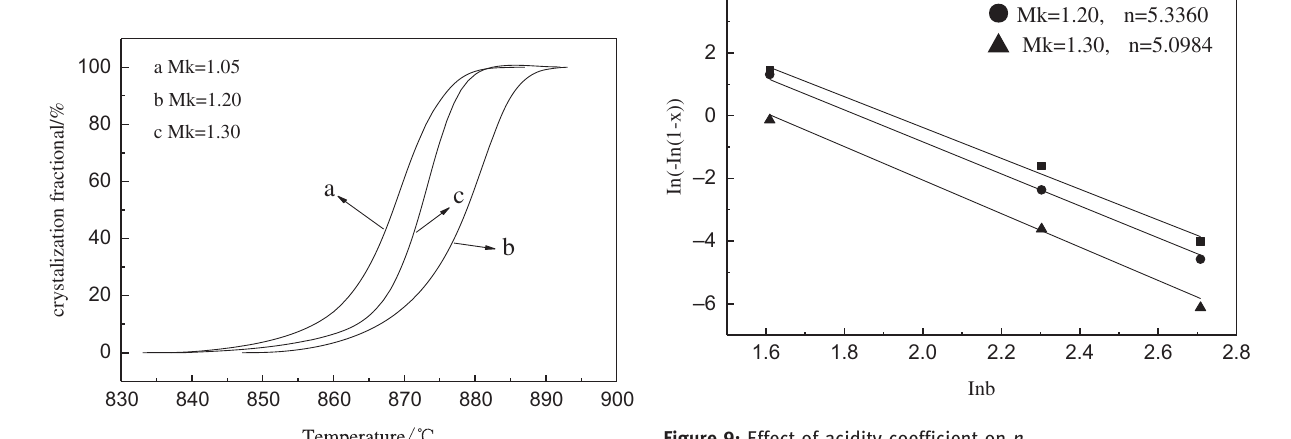
Figure 9: Effect of acidity coefficient on n